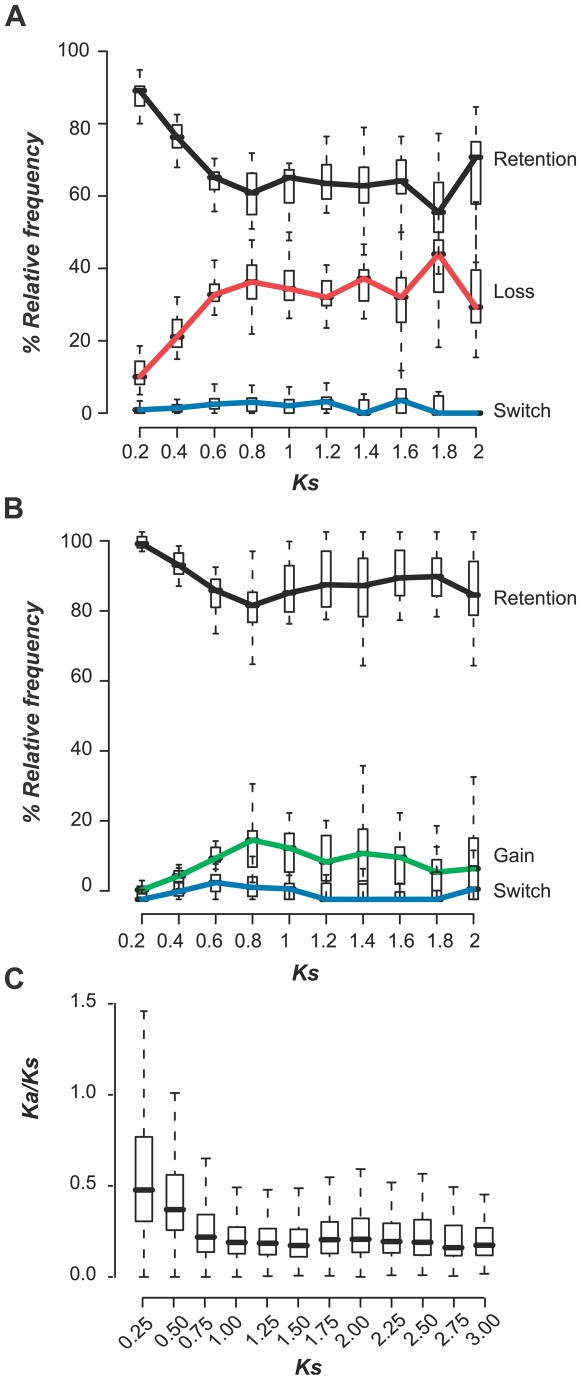
Relationship between stress evolution scenarios and Ks.(A) The relative abundance of external branches exhibiting retention, loss, and switch of stress response was determined for each of the 8 abiotic stress conditions. Here we only show ancestral-extant pairs where the ancestral gene was up-regulated in ≥1 conditions. In each Ks bin, the relative frequency of each stress evolution scenario (number of extant genes with retention, loss, or switch over the total number of extant genes) is summarized as a box plot (including values from all conditions/times). A colored line connects the median values to indicate the trend over Ks. Black line: retention. Red: loss. Switch: blue. (B) The relative abundance of external branches with retention, gain, and switch under abiotic stress conditions. Only ancestral-extant gene pairs where extant genes were up-regulated in ≥1 conditions were considered. Boxplots were generated as described in (A). Black line: retention. Green: gain. Blue: switch. Similar plots for biotic stress conditions, for down-regulated genes, and for each condition are shown in Figure S2. (C) Ka/Ks-over-Ks plot of A. thaliana duplicates (reciprocal best match within species). The Ka/Ks values were separated into multiple Ks bins. For all box plots: black bars indicate median values, boxes delineate 1st and 3rd quartiles, and dotted lines delineate 1–99 percentiles.